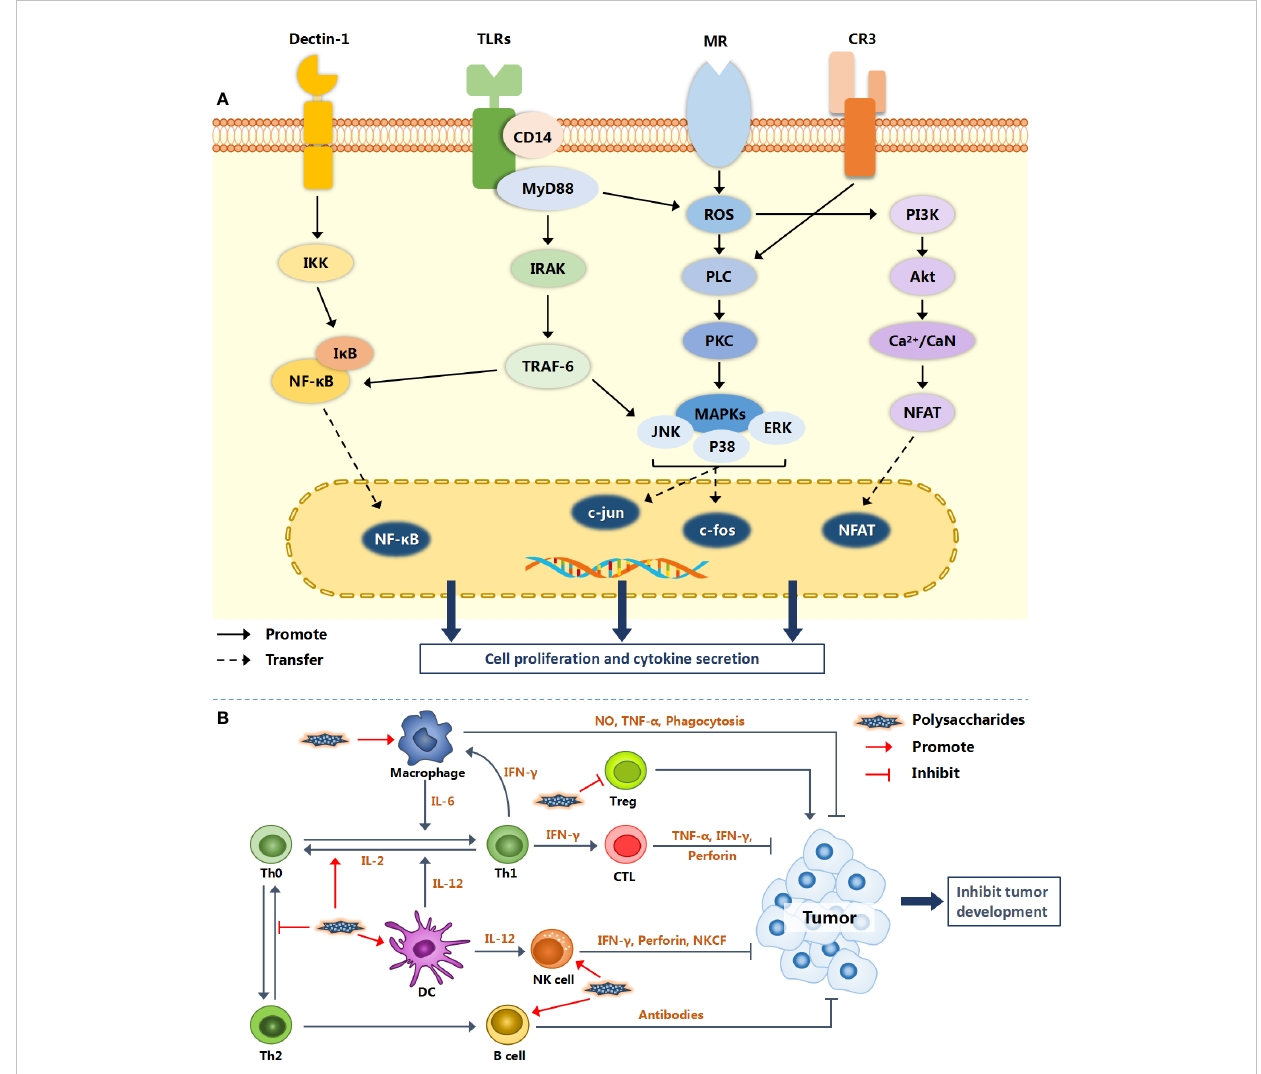
FIGURE 2 Immunomodulatory mechanism of natural polysaccharides. Natural polysaccharides activate intracellular signaling pathways via a variety of surface receptor binding modes (TLRs, Dectin-1, MR and CR3), and fi nally promote the proliferation and activation of immune cells [shown in (A) ]. Various immune cells interact with each other to form an immune regulation network, resulting in inhibiting the growth and metastasis of tumor [shown in (B)